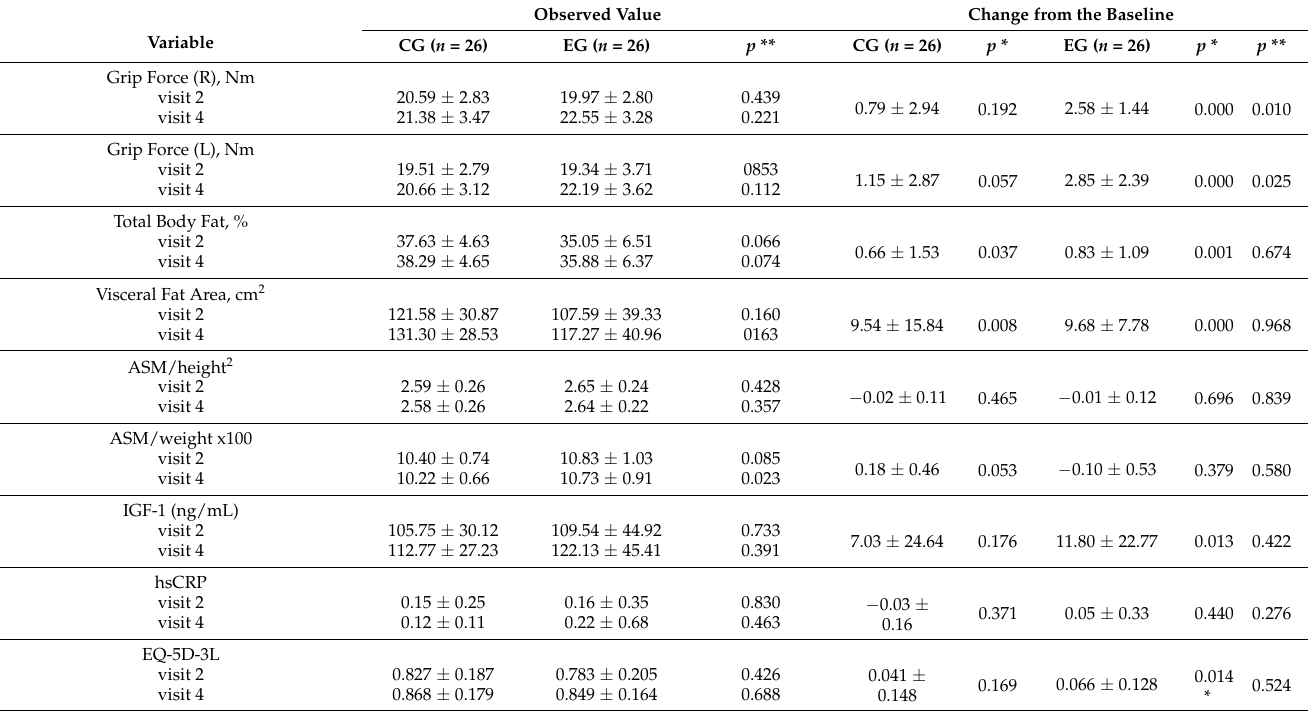
Table 6. Secondary outcome comparisons between and within each group (ITT